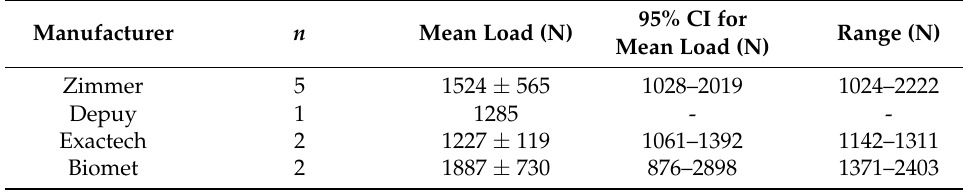
CI = confidence interval. Table 2. Implant group mean load to Table 3. Mean rotation and torsional stiffness for each implant.